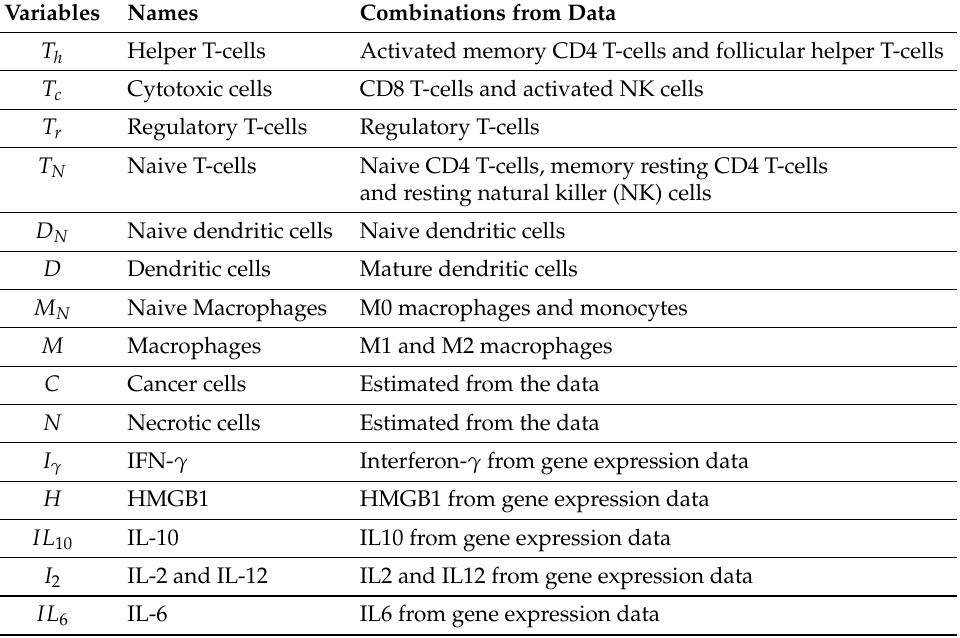
Table 1. Variables and their correspondence to